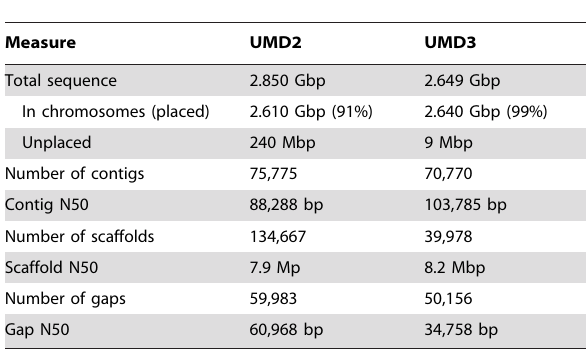
Table 1. Assembly statistics for UMD2 and